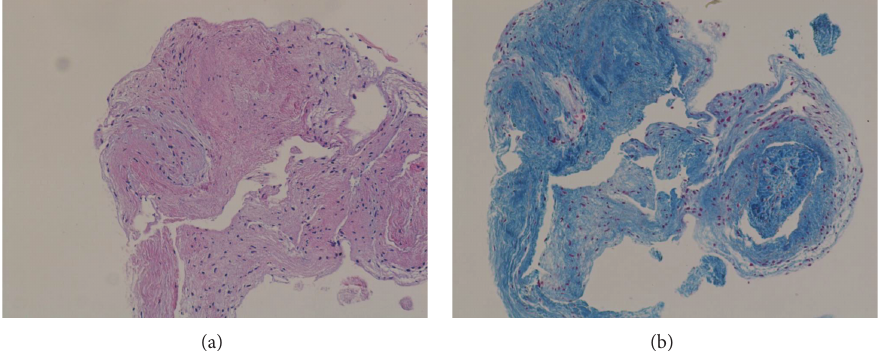
Figure 5: Histological findings. Hematoxylin and eosin staining, 10x magnification (a), and Azan staining, 10x magnification (b), of endomyocardial biopsies from the right ventricular septum. Thickened fibrous endomyocardium extended through all layers of each